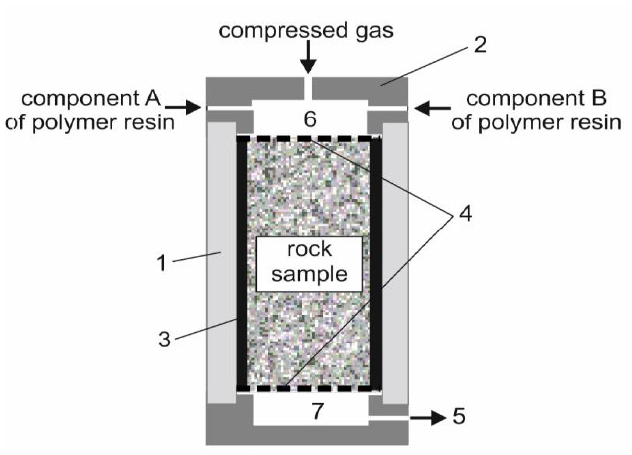
Figure 3. Test chamber of the laboratory stand to reinforce loose rocks: 1 — metal case; 2 — cover containing three inlets to pump solutions and compressed gas into a rock; 3 — cylindrical shell; 4 — perforated permeable plates; 5 — outlet; 6 — mixer; 7 — receptacle.